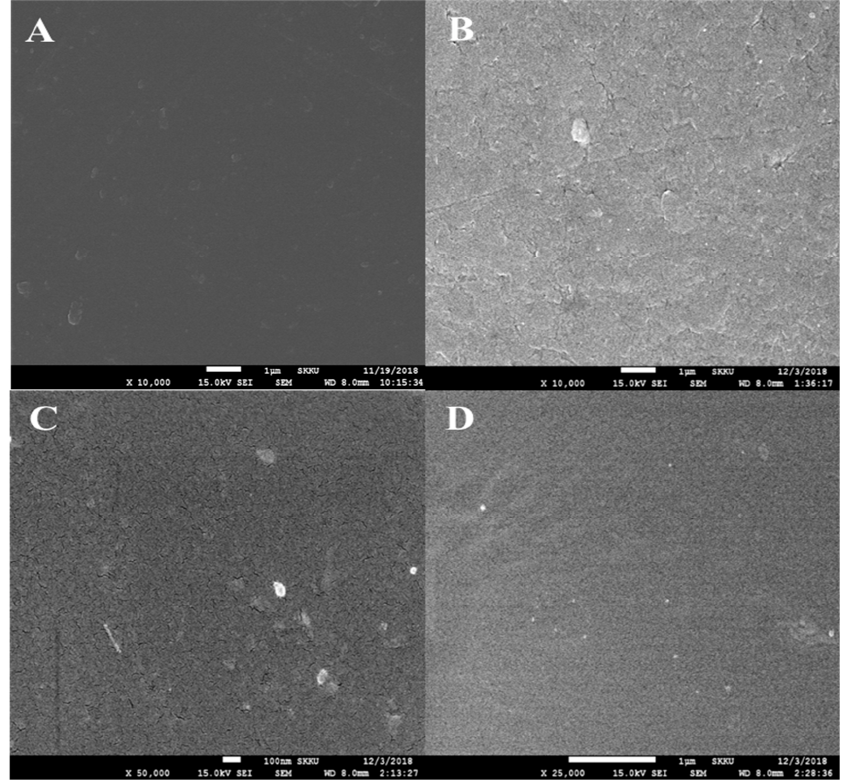
Figure 4. FE-SEM for ( A ) SPEES, ( B ) SPEES-AM-01, ( C ) SPEES-AM-02, ( D ) SPEES-AM-03.